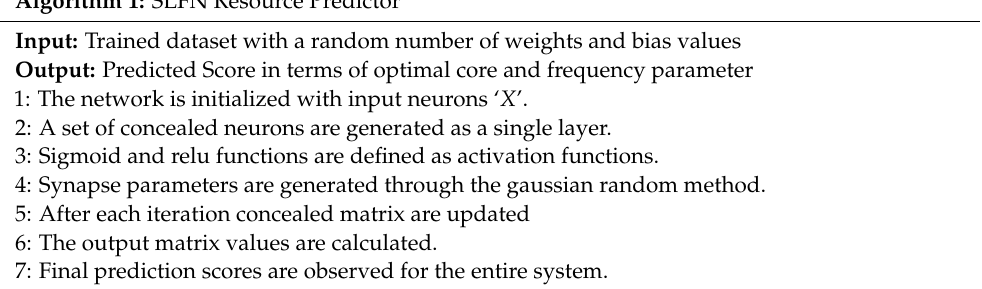
Algorithm 1: SLFN Resource